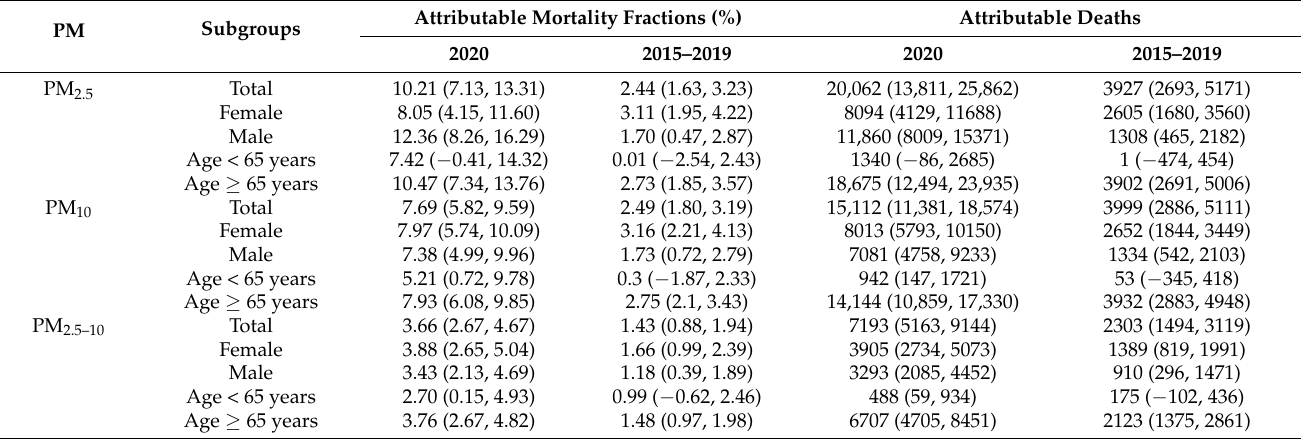
Table 2. Attributable fractions and attributable counts of all-cause mortality due to PM 2.5 , PM 10 , and PM 2.5–10 during March to May in 2020 and 2015–2019, respectively. PM